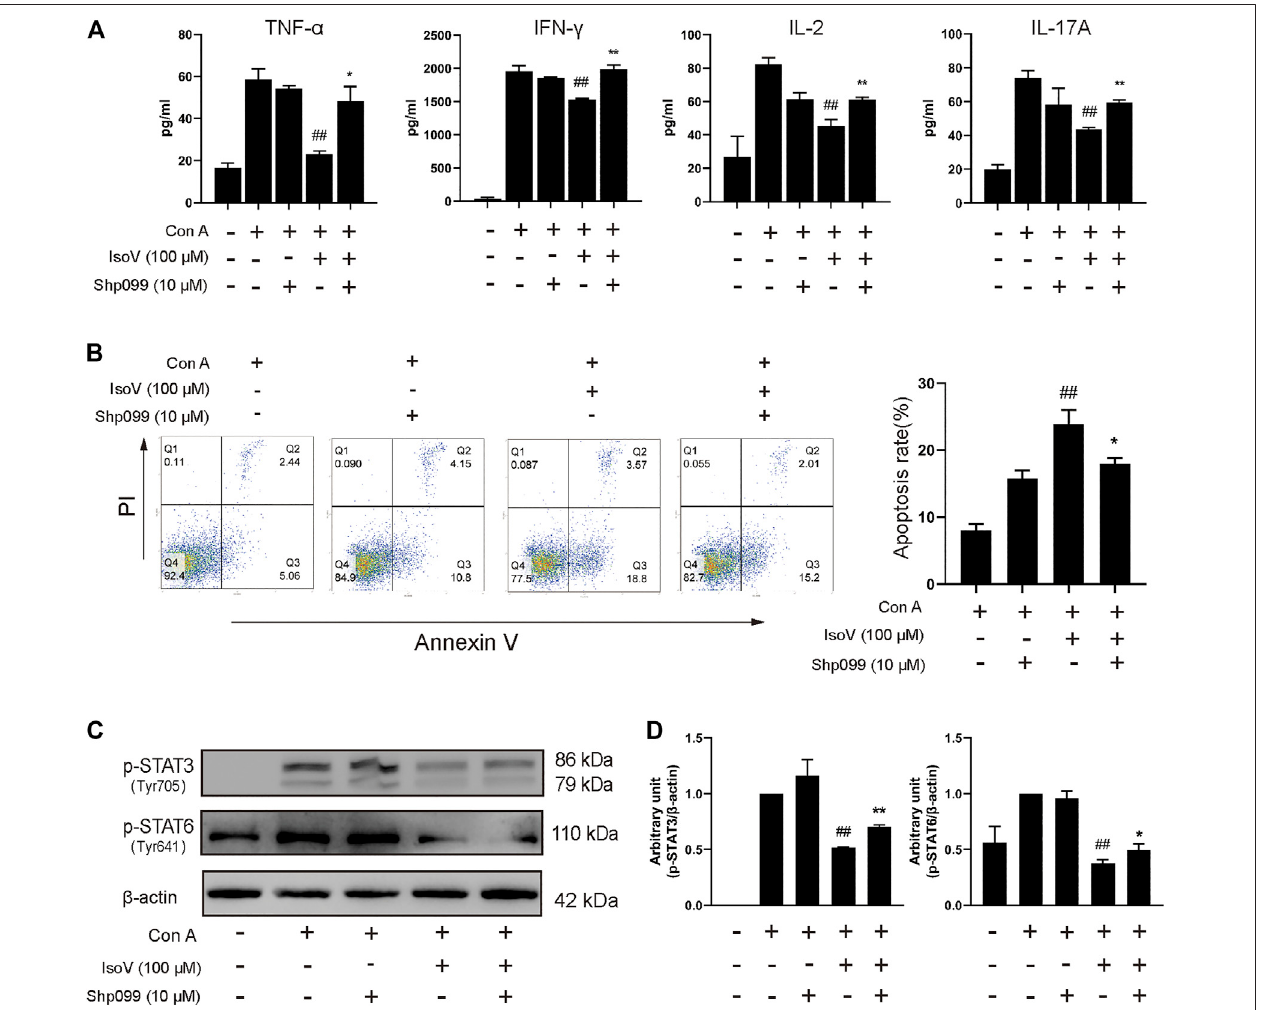
FIGURE 7 | The SHP2-speci fi c inhibitor SHP099 reversed the effects of isovitexin on activated T cells. Con A-activated T cells were treated with 100 μ M isovitexin and added with 10 μ M SHP2 or not; (A) The levels of proin fl ammatory cytokines in cell culture supernatants were determined using ELISA kits after 24 h cultivation. (B) CellswerestainedwithAnnexinVandPI,andtheapoptosisofthecellswasdeterminedby fl owcytometryassayofAnnexinV/PIstaining.AnnexinVpositivecellsofthree independent experiments wereshown incolumn statistics. (C,D) Lymph nodes cellswere harvested and lyzedand thephosphorylationofSTAT3 and STAT6 was evaluated by Western blot. The grouping of blots was cropped from different parts of the same gel. Data are mean ± SEM and are representative of two independent experiments. Signi fi cant differences are expressed as ## p < 0.01 vs. Con A group, * p < 0.05, ** p < 0.01 vs. the isovitexin group.